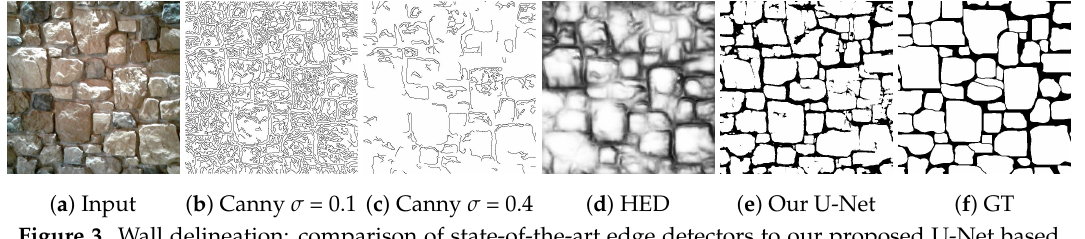
Figure 3. Wall delineation: comparison of state-of-the-art edge detectors to our proposed U-Net based approach, and to the Ground Truth